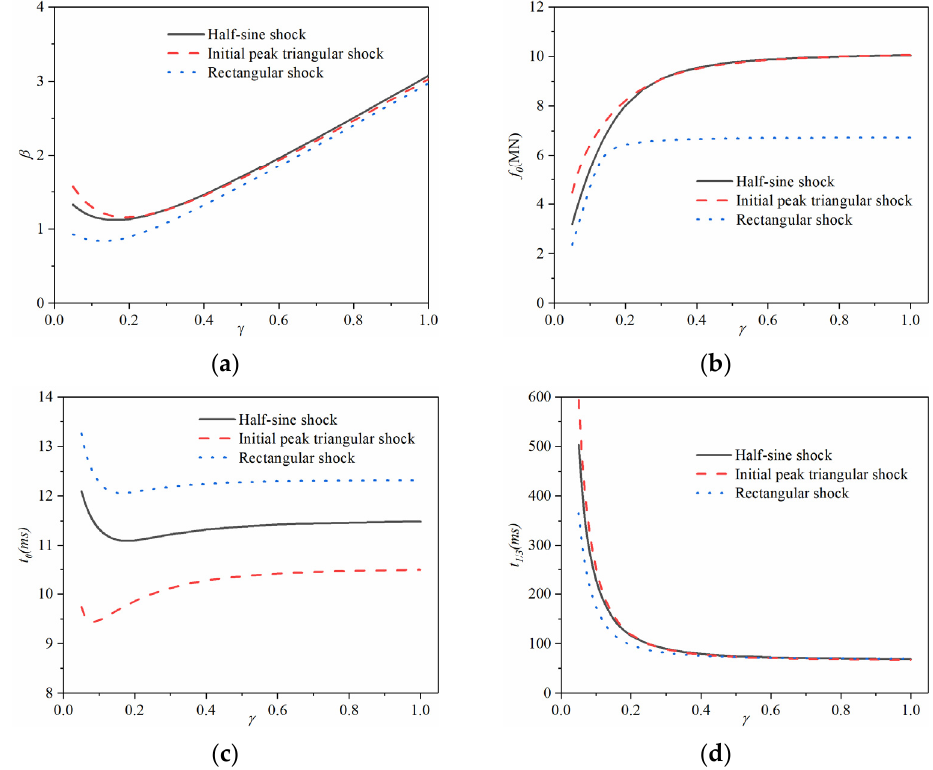
Figure 6. Parameter of the ECD and responses of the SDOF system with the ECD subjected to three forms of shock excitation: ( a ) The dimensionless damping force of the ECD; ( b ) The peak damper force; ( c ) The time to reach the intended maximum displacement; and ( d ) The time to decay to one-third of the intended maximum displacement.